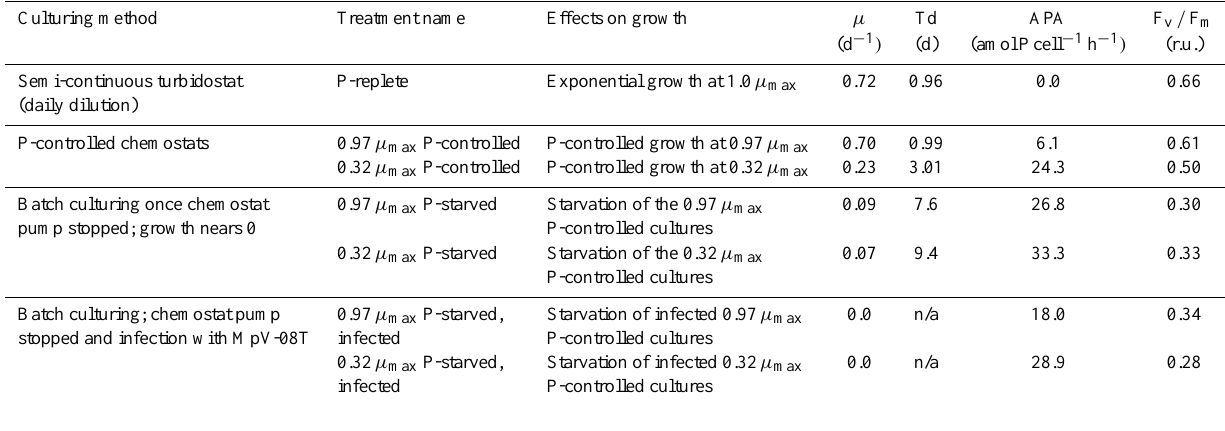
Table 1. P treatments used in the cultivation experiments of M pusilla and corresponding effects on growth rate ( µ ), doubling time (Td), alkaline phosphatase activity (APA) and photosynthetic efficiency (F v / F m ). All experiments were carried out in the same vessels and under the same conditions (light, other nutrients, temperature, etc.). n/a is not